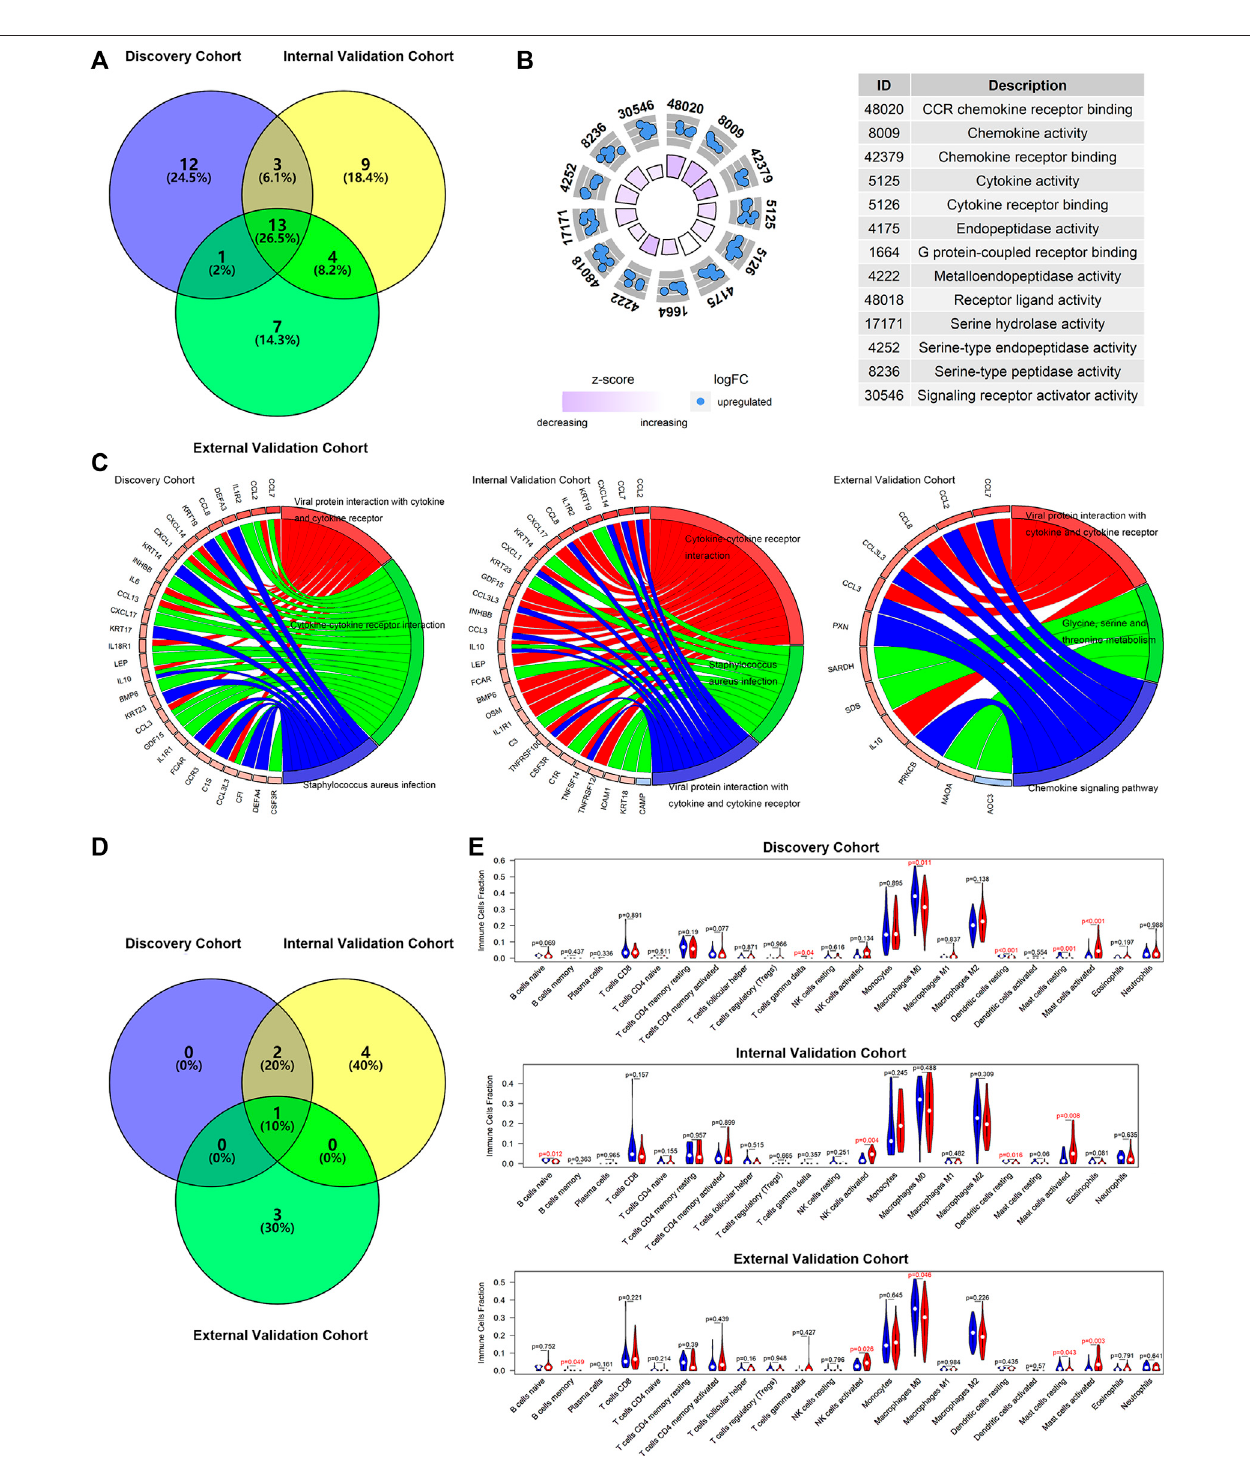
FIGURE 8 | The potential molecular mechanisms of m7GPS in IPF. (A) Selection of overlap molecular functions of m7GPS in the three cohorts. (B) The panel was drawnbasedonthevalidationcohortwiththeoverlappedmolecularfunctionsofm7GPSinthethreecohorts. (C) KEGGsignalingpathwaysofthem7GPSarebasedon thethree cohorts. (D) SelectionofKEGGsignaling pathways ofm7GPSinthethreecohorts. (E) The immune cellfraction levelsbetweenpatients withhigh- andlow-risk scores; p -value was calculated based on Wilcoxon rank-sum test.